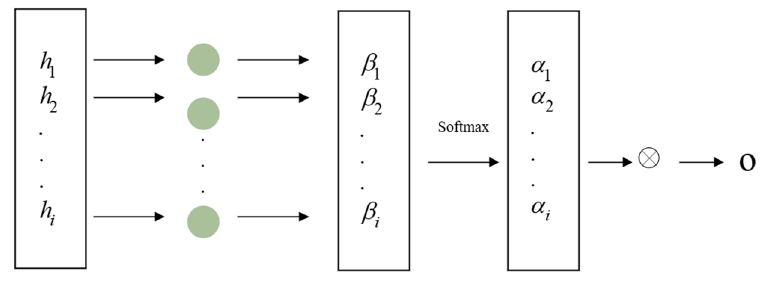
Figure 4. Attention network structure diagram. Green circles represent neurons.